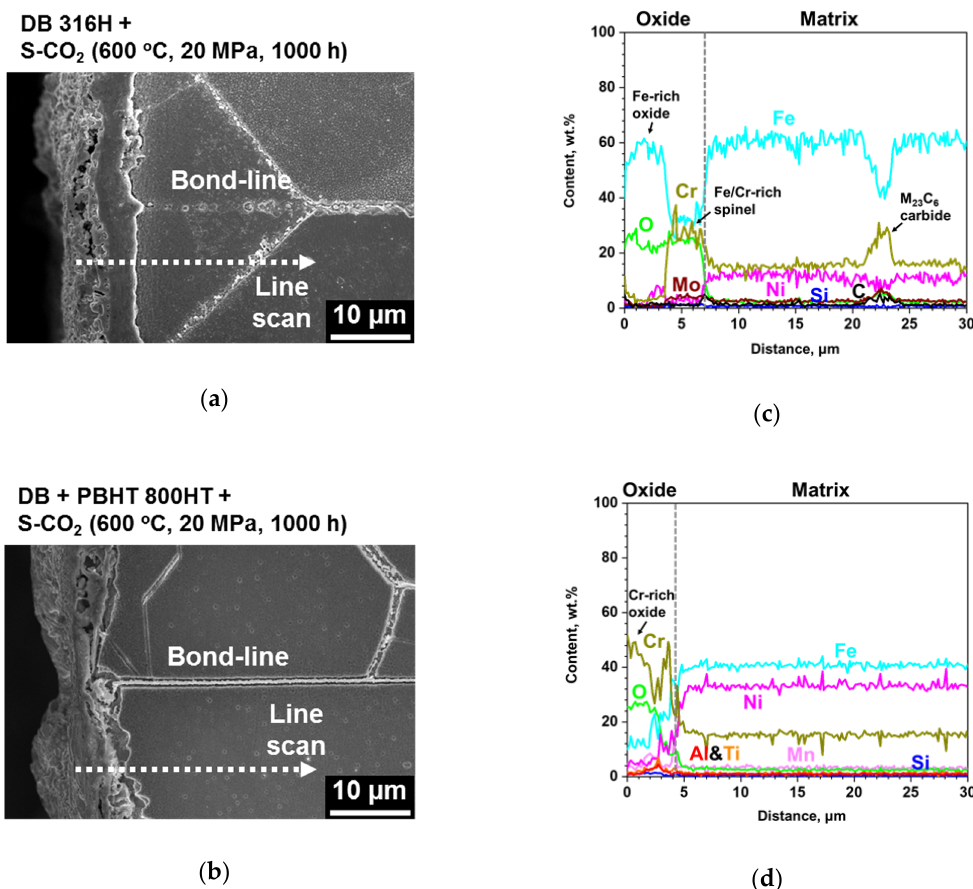
Figure 7. Cross-sectional SEM micrographs of ( a ) di ff usion bonded SS 316H and ( b ) PBHT-ed Alloy Figure 7. Cross ‐ sectional SEM micrographs of ( a ) diffusion bonded SS 316H and ( b ) PBHT ‐ ed Alloy 800HT, and EDS line scanning of ( c ) di ff usion bonded SS 316H and ( d ) PBHT-ed Alloy 800HT showing 800HT, and EDS line scanning of ( c ) diffusion bonded SS 316H and ( d ) PBHT ‐ ed Alloy 800HT oxides at the bond-line region after S-CO 2 exposure at 600 ◦ C (20 MPa) for 1000 showing oxides at the bond ‐ line region after S ‐ CO 2 exposure at 600 °C (20 MPa) for 1000 h.